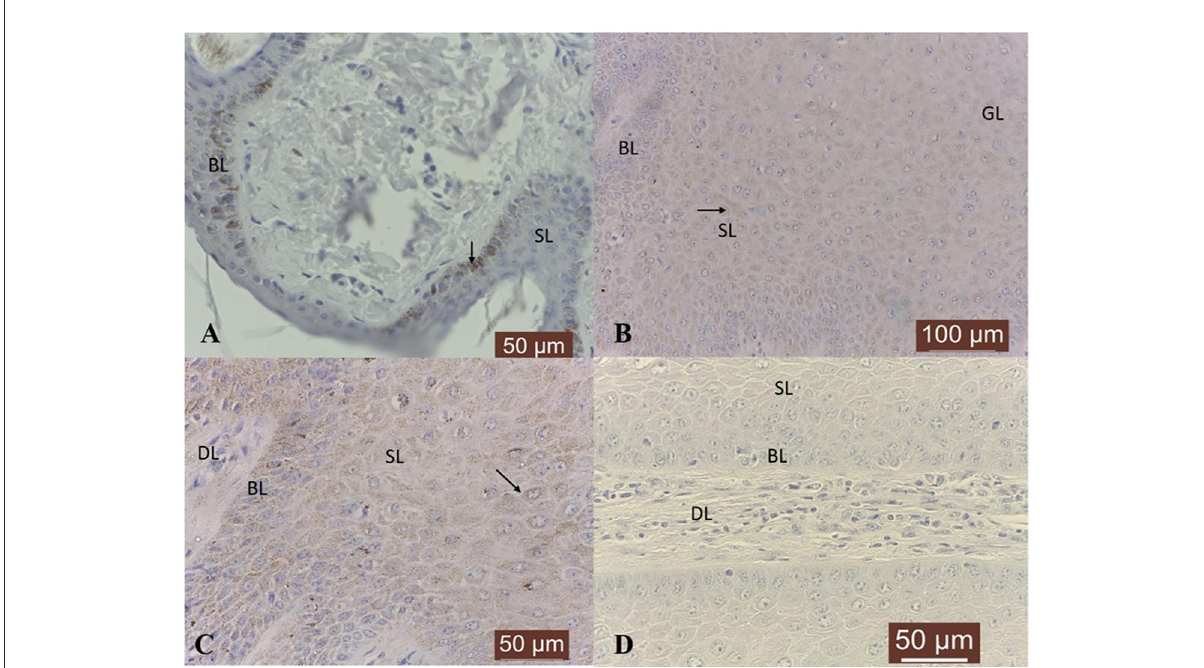
FIGURE7 TIMP-2 immunoexpression in bovine normal skin and fibropapillomas: (A) TIMP-2 moderate granular cytoplasmic pattern (black arrow) mainly in basal layer (BL) of normal skin; 40 X. (B) Most tumor cells from spinosum (SL) and granular (GL) layers exhibited cytoplasmic (black arrow) TIMP-2 immunosignal; 20 X. (C) Note a weak to moderate granular cytoplasmic and perinuclear pattern (black arrow) in keratinocytes from BL and SL; 40 X. (D) Negative control: fibropapilloma with the first antibody anti-TIMP-2 omitted and incubated with secondary antibody did not stain; 40 X.